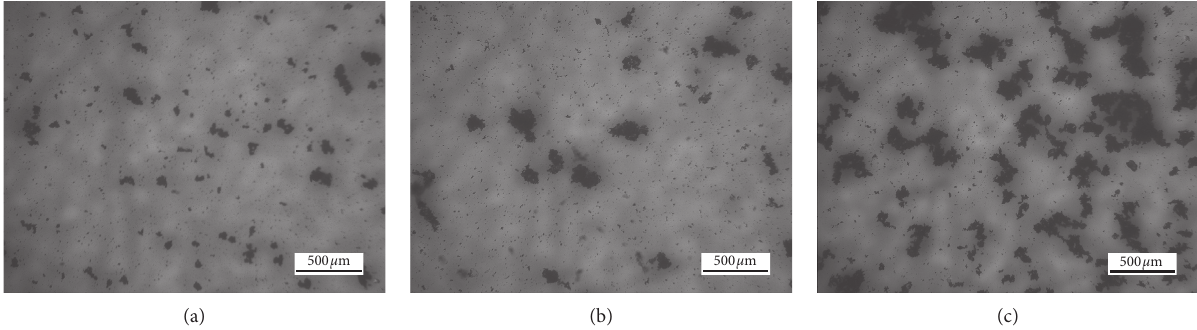
Figure 11: Particles ( − 10 μ m) in 1mM sodium oleate solution at pH 10: (a) scheelite-scheelite and scheelite-calcite; (b) scheelite-fluorite; (c)